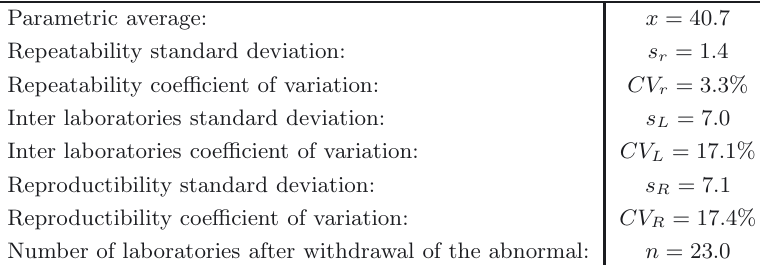
Table 3. Statistical balance of the laboratory network for the histamine amount (mg/kg), in the level 1 PTS